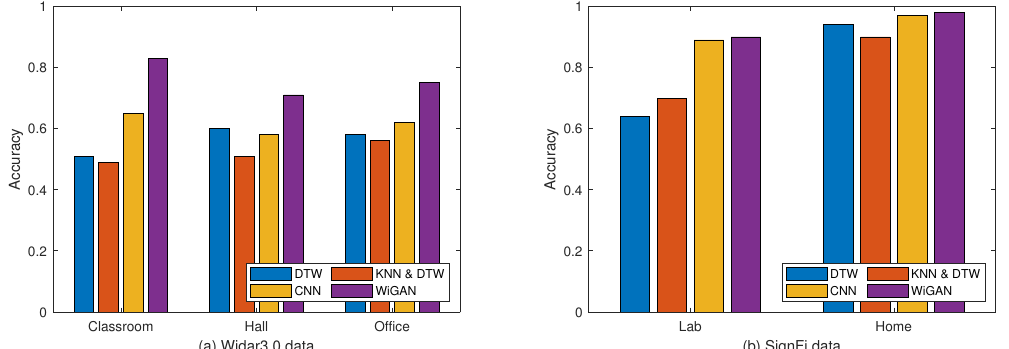
Figure 6. Comparison of the recognition accuracy of different environments on the two data. ( a ) Widar3.0 data. ( b ) SignFi data.